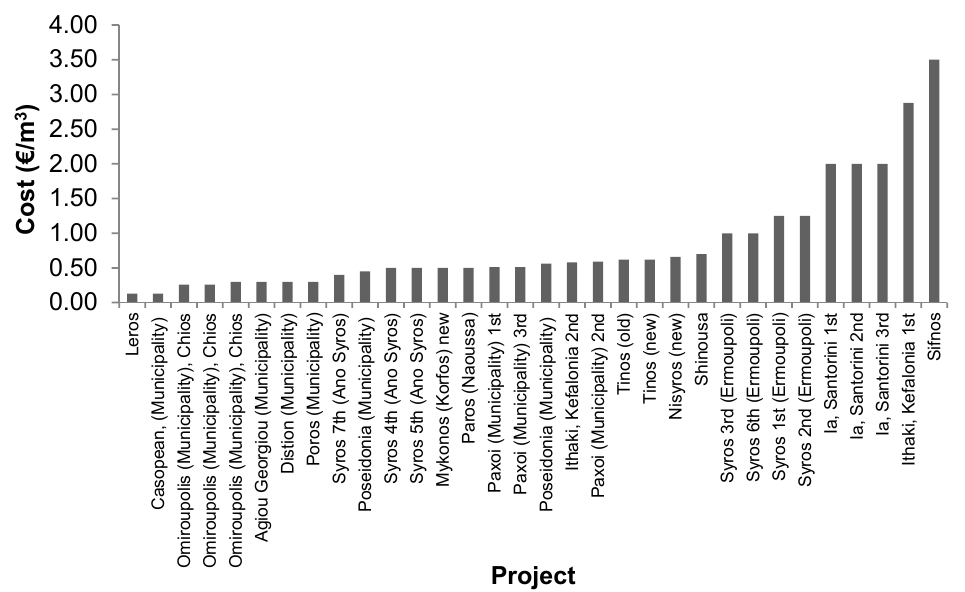
Figure 7. Operating cost (€/m 3 ) of seawater RO desalination plants in the Hellenic islands. Adapted from